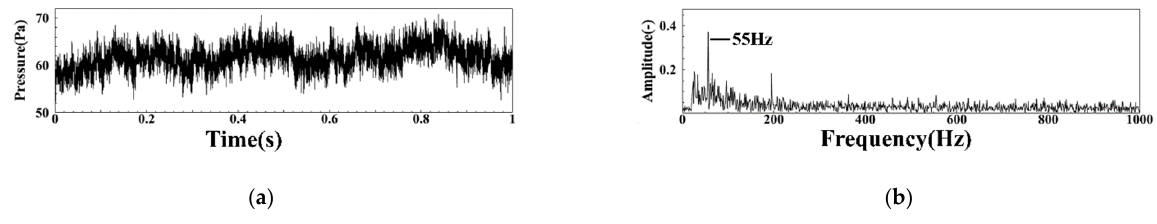
Figure 20. DP spectrum in combustor without inlet air: ( a ) DP signal; ( b ) Spectrum. The dimensionless DP pulsation spectrum of the intake air flow of groups LB and LC is obtained after a similar noise reduction treatment for the DP signal in the case of only the air supply without ignition as shown in Figure 21a,b. There is a pulsating dominant frequency near 50 Hz in the frequency spectrum under the two air intakes, which is consistent with the pulsating dominant frequency when there is no ventilation, indicating that 50 Hz is a fixed power frequency. There is a sub-peak dominant frequency of 61 Hz and 77.3 Hz in the DP spectrum of each air intake. The reason for this result is that when the inlet air passes through the cyclone blade, it will produce stress change after being subjected to cyclone shear, which will further cause the change of the DP pulsation dominant frequency.